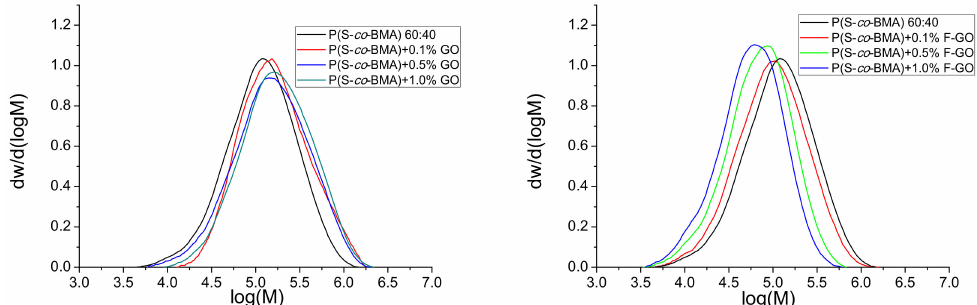
Figure 5. Molecular weight distribution of neat P(S- co -BMA) 60:40 and its nanocomposites with either GO ( a ) or F-GO ( b ) obtained after bulk in-situ radical